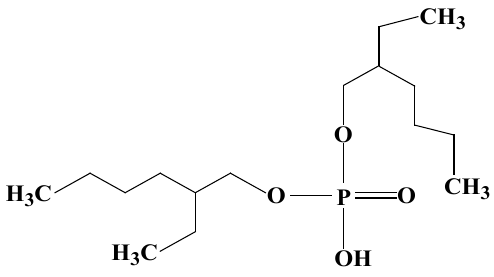
Figure 3. Molecular structure of P204.